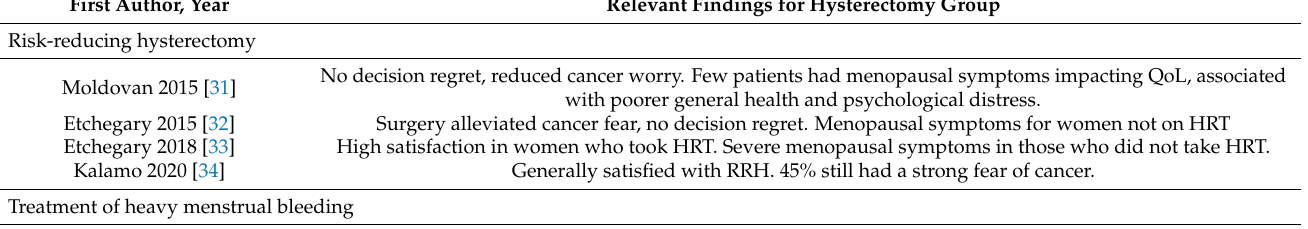
Table 2. Summary of main